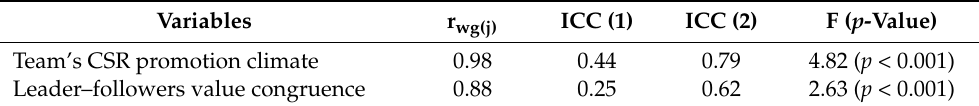
Table 2. Aggregation Test Results for Group-Lever Variables.